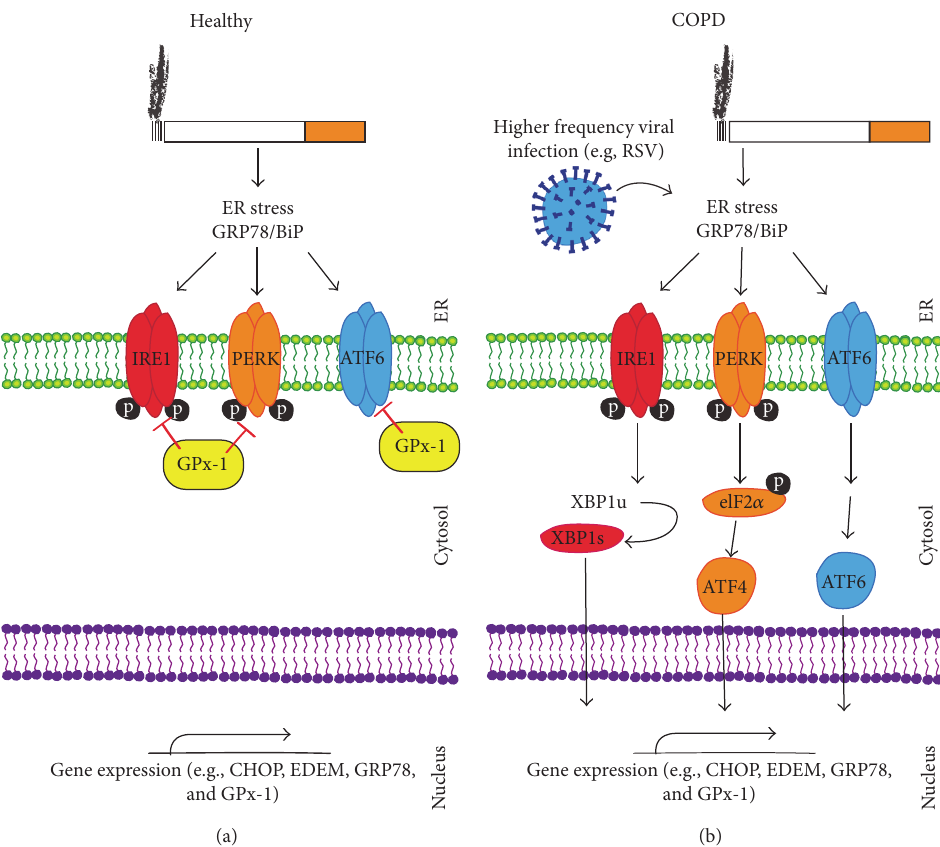
Figure 8: Possible signaling mechanism for GPx-1 regulation of the UPR. Evidence presented in this study indicates that following smoke exposure GPx-1 prevents ER stress (a). However, in the disease-state GPx-1 expression is subdued and results in enhanced UPR (b). RSV infection significantly contributes to reduced GPx-1 expression that coincides with enhanced